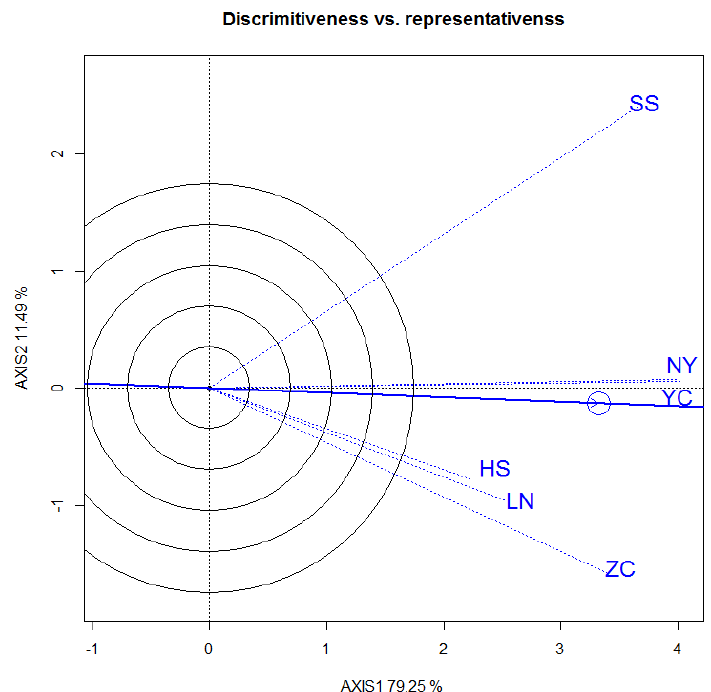
Figure 4. Discrimitiveness and representativeness of tree height of 6 sites. The smaller the angle with the blue solid line, the greater the representativeness; the longer the length of the dashed line, the greater the discrimitiveness. The angle between the dotted lines can reflect the correlation between the locations; the smaller the angle, the more positive the correlation.